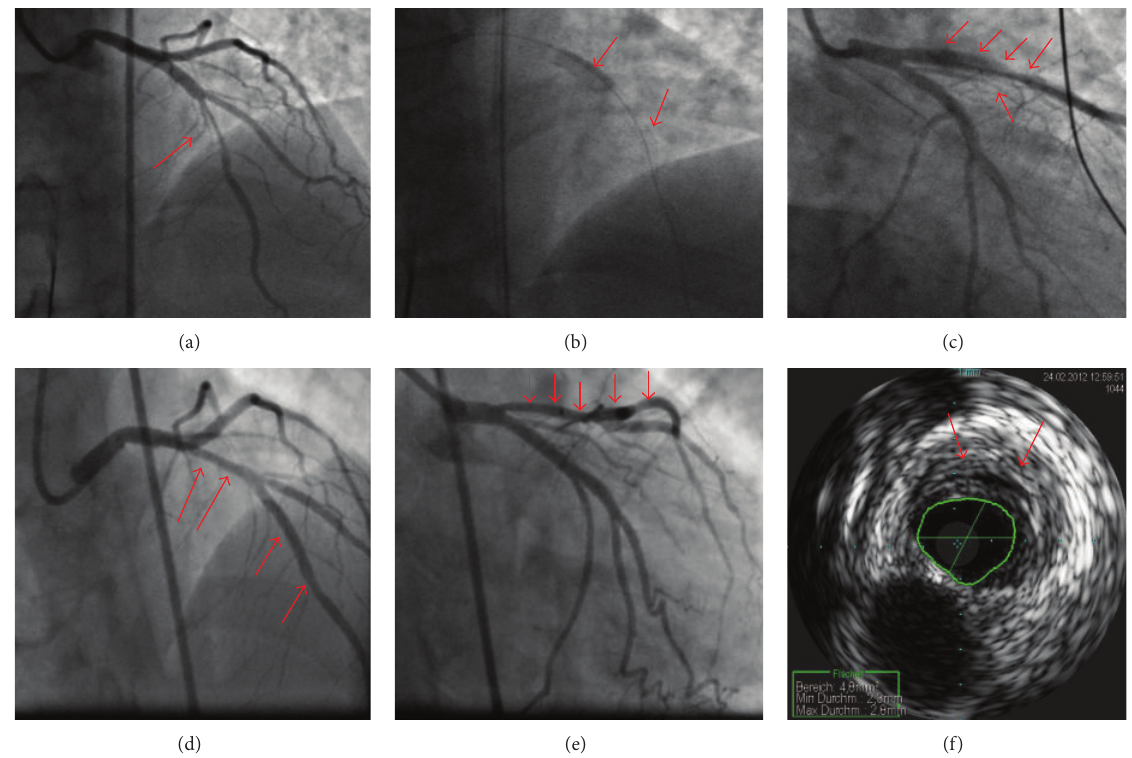
Figure 1: In (a), the mid LAD lesion is clearly seen before wiring. In (b) and (c), an iatrogenic dissection after stenting is clearly visible with proximal extension. The 2nd angiogram (d and e) shows narrowing of the LAD proximal to the placed stents. (f) shows IVUS confirmation of the diagnosis and estimation of minimum luminal area (4.8 mm 2 ); so, the decision was made not to intervene based on IVUS result.